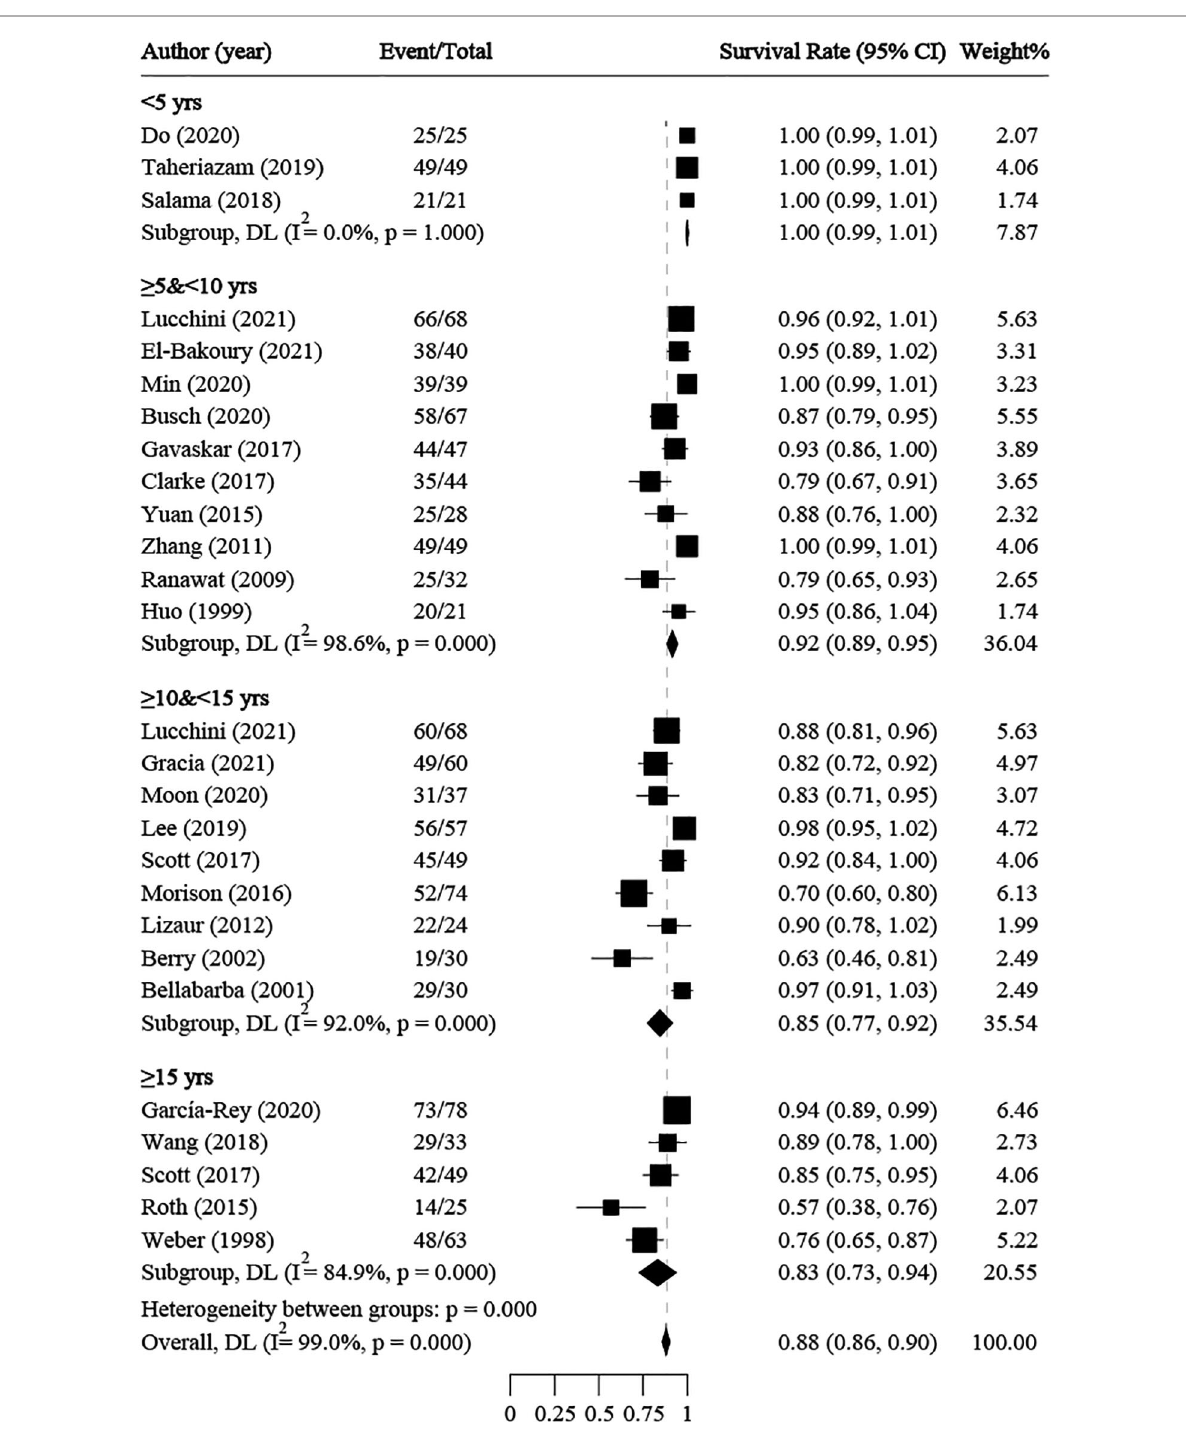
FIGURE 3 Overall and subgroup meta-analyses for implant survival